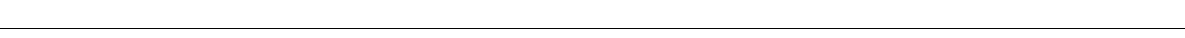
Figure 7 | hCINAP depends on its adenylate kinase activity to promote CRCs growth and invasion. ( a , b ) Nude mice were subjected to orthotopic injection with CRCSCs expressing shRNAs and vectors as indicated and administrated with doxycycline 6 days later. The mice were then sacrificed 6 days later, after which tumours were collected, followed by photography and measurement. The tumour volumes from mice were quantified by paired t -test ( n ¼ 8), NS, not significant, *** P o 0.001. ( c ) Western blot analysis of LDHA Y10 phosphoryaltion in CRCSCs (without doxycycline administration) and tumour extract from xenograft mice (with doxycycline treatment). ( d ) LDHA Y10 phosphorylation levels in CRCSCs transfected as indicated in western blot. ( e ) Migration assay of SW480 cells and quantification of cells migration potential and proliferation rate. ( f , g ) Tumorsphere formation assay for CRCSCs in d and quantification by t -test ( n ¼ 3), NS, not significant, *** P o 0.001. ( h ) Limiting dilution assay for CRCSCs in d . Tumour-initiating frequency was calculated by extreme limiting dilution analysis (NS, not significant, *** P o 0.001). ( i ) Immunofluorescence assay for the effect of hCINAP knockdown by shRNA and hCINAP wild-type or H79G mutant rescue expression on the mesenchymal–epithelial transition in CRCSC spheres. Vimentin (red), E-cadherin (green) and the nucleus (DAPI, blue). Scale bar, 100 m m. ( j ) A schematic working model to illustrate that hCINAP promotes the Warburg effect to maintain CRCSCs survival and self-renewal through its adenylate kinase activity-dependent upregulation of LDHA Y10